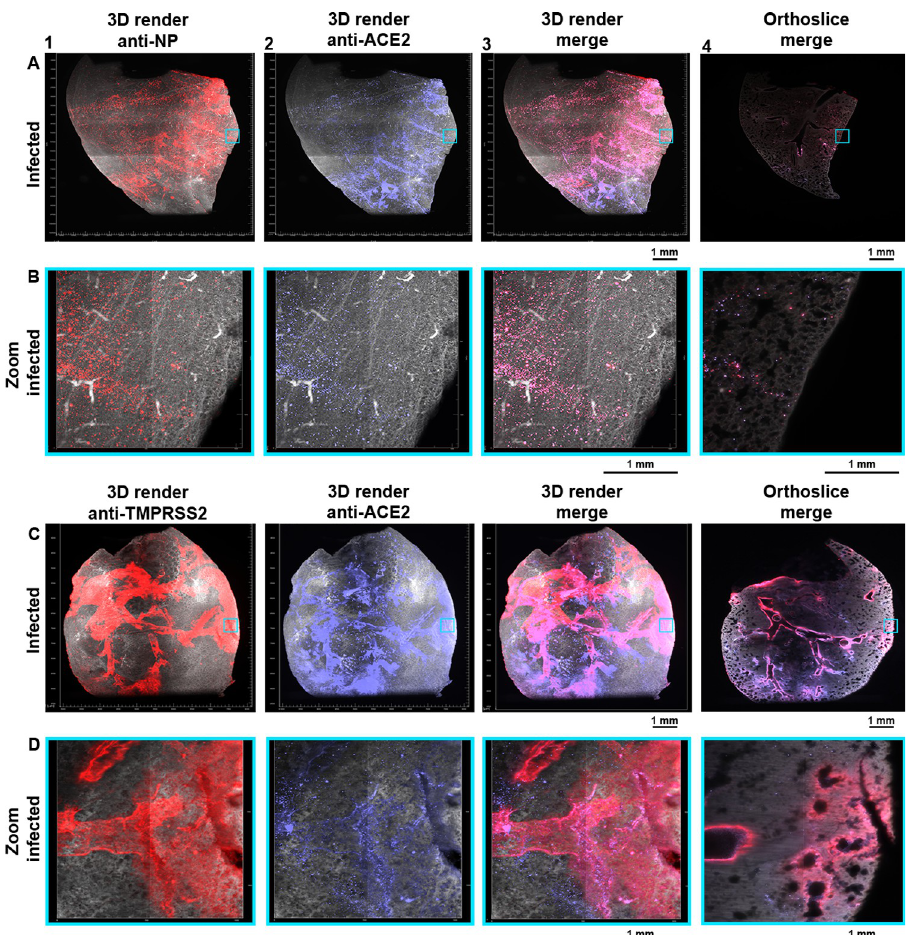
Fig 4. Visualizing tropism of SARS-CoV-2 infection with ACE2 and TMPRSS2 expression patterns at 4-dpi. Autofluorescence in grey (488 channel), co-staining in red (647 channel), and purple (730 channel), with overlapping regions in pink (colorblind-proof). (A) In several regions of the lung, NP staining is observed from the secondary bronchi extending to the tertiary bronchi, a top-to-bottom gradient. ACE2 is again a bottom-to-top gradient, with signals in the alveoli and various tertiary bronchi. There is a major overlap of NP with ACE2 in the tertiary bronchi, bronchioles, and alveoli (foci). In the lower portion of the lung, there is no apparent overlap of NP and ACE2. 0.63 zoom, voxel resolution X,Y,Z: 4.79 μ m, 4.79 μ m, 5 μ m. (B) In the alveoli there is a significant overlap of NP and ACE2, the previously observed foci appear to be alveolar. Several NP-stained foci do not superimpose with ACE2 stained foci. 6.3 zoom, voxel resolution X,Y,Z: 0.48 μ m, 0.48 μ m, 2 μ m. (C) The expression profile of TMPRSS2 in infected Syrian hamster lungs is highly similar to the expression in non-infected lungs. The fluorescence signal is spreading towards the bronchioles. Likewise, ACE2 expression is also highly similar to mock lungs, with protein staining in tertiary bronchi and bronchioles, 0.63 zoom, voxel resolution X,Y,Z: 4.79 μ m, 4.79 μ m, 5 μ m. (D) At the transitioning point of bronchioles and alveoli TMPRSS2 and ACE2 superimpose, whilst in the alveoli only ACE2 expression is present. 6.3 zoom, voxel resolution X,Y,Z: 0.48 μ m, 0.48 μ m, 2 μ m. MP4 files of 3D render and orthoslice merges are provided. expression profile was observed compared to the duplicate experiment in non-infected lungs (Fig 2). Substantial TMPRSS2 expression was detected in the primary, secondary and tertiary bronchi, with a spread to the bronchioles and alveoli, similar to previous single and double stains with alveolar staining at the transitioning point of the bronchioles and alveoli (Figs 4C1, 4D1, S7C, and S7D). ACE2 expression peaks enormously in the tertiary bronchi, bronchioles, and alveoli (Figs 4C2, 4D2, S7C, and S7D), with clearly lower signal in the primary and sec- ondary bronchi (Figs 4C2 and S7C). The overlap of ACE2 and TMPRSS2 is predominantly